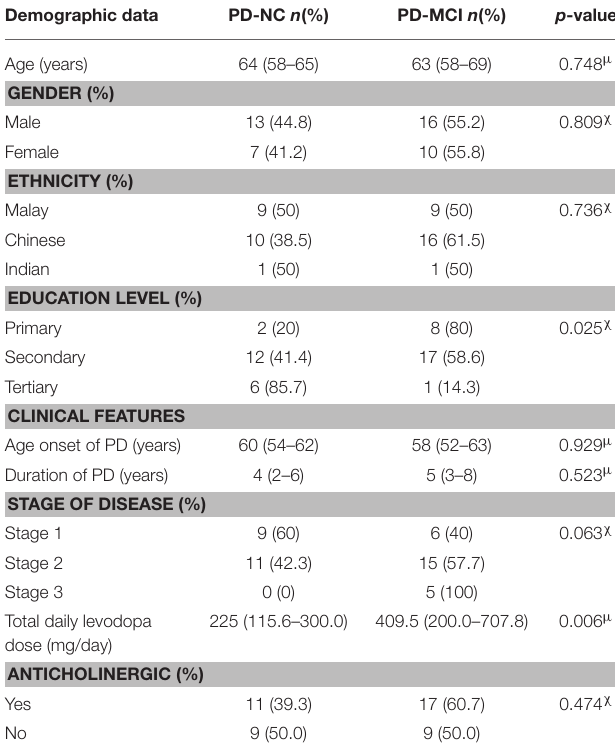
TABLE 1 | Demographic and clinical data of PD-NC and PD-MCI